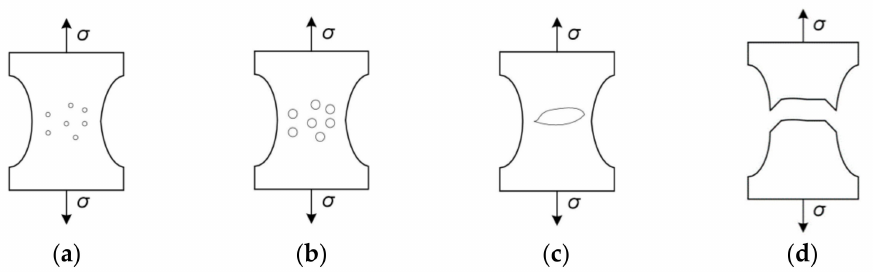
Figure 2. Phases of void development: ( a ) nucleation of voids; ( b ) growth; ( c ) coalescence; ( d )